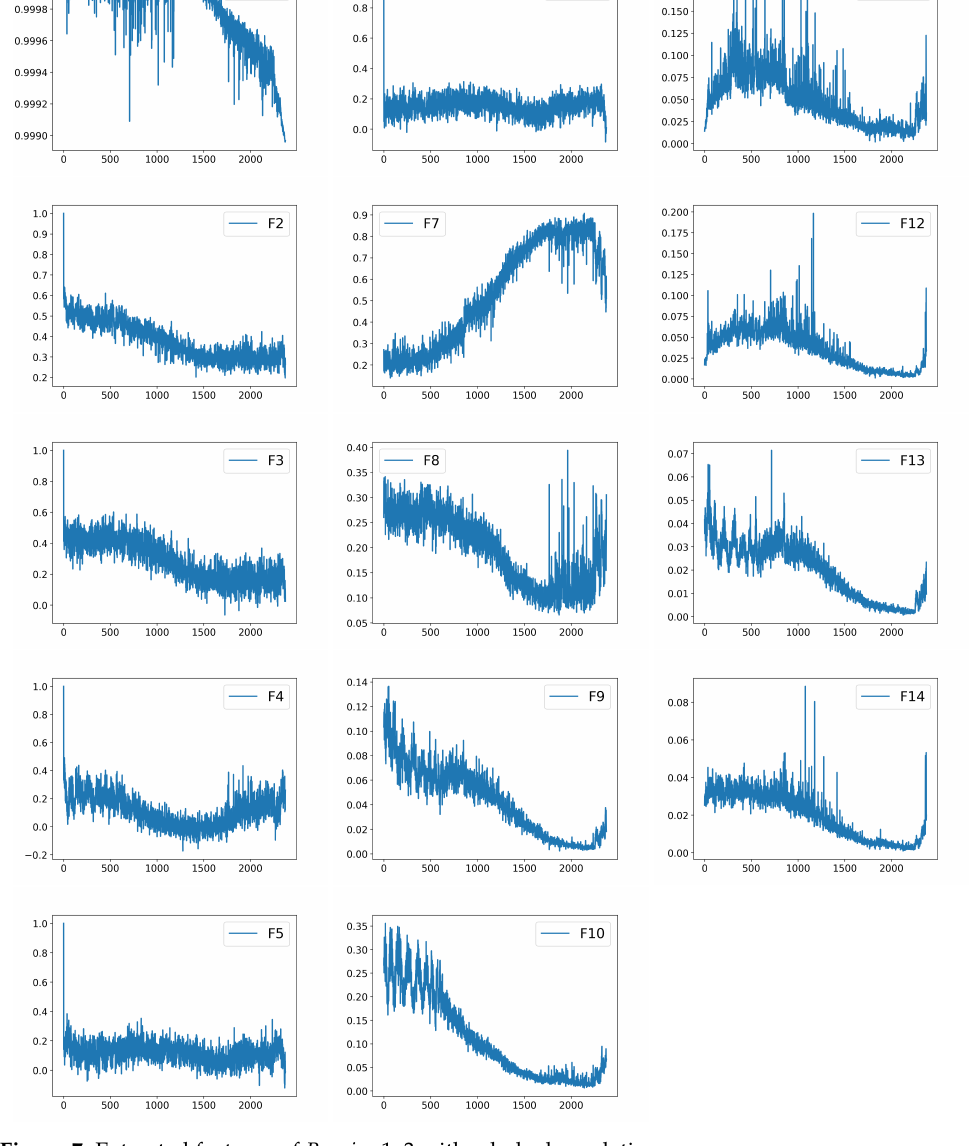
Figure 7. Extracted features of Bearing 1_3 with whole degradation